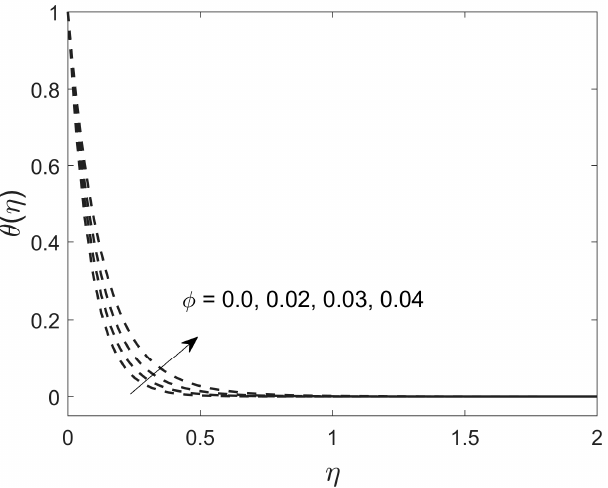
Figure 15. Effect of the nanoparticle volume fraction on the temperature distribution.